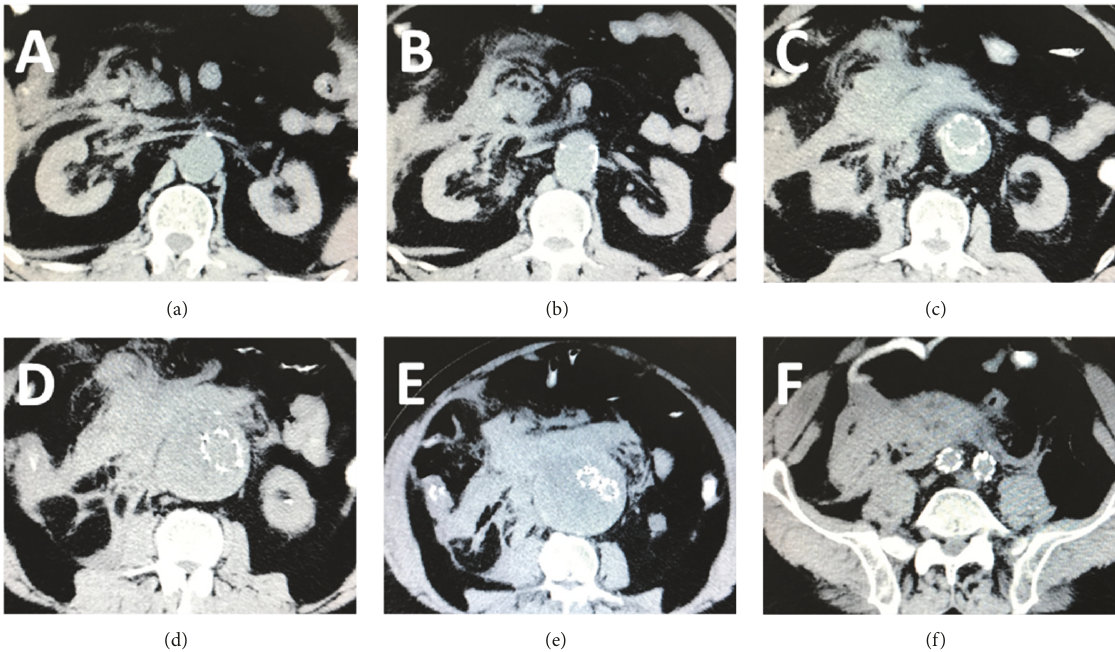
Figure 1: Preoperative CT scan. Contrast media had to be avoided due to severe renal failure. The Talent stent-graft was migrated and the proximal sealing was lost ((a)–(c)) leading to potential type I endoleak, sac enlargement, and rupture. A leaking 9cm AAA with a huge retroperitoneal hematoma was depicted ((d) and (e)). Distal iliac sealing was sufficient (f).